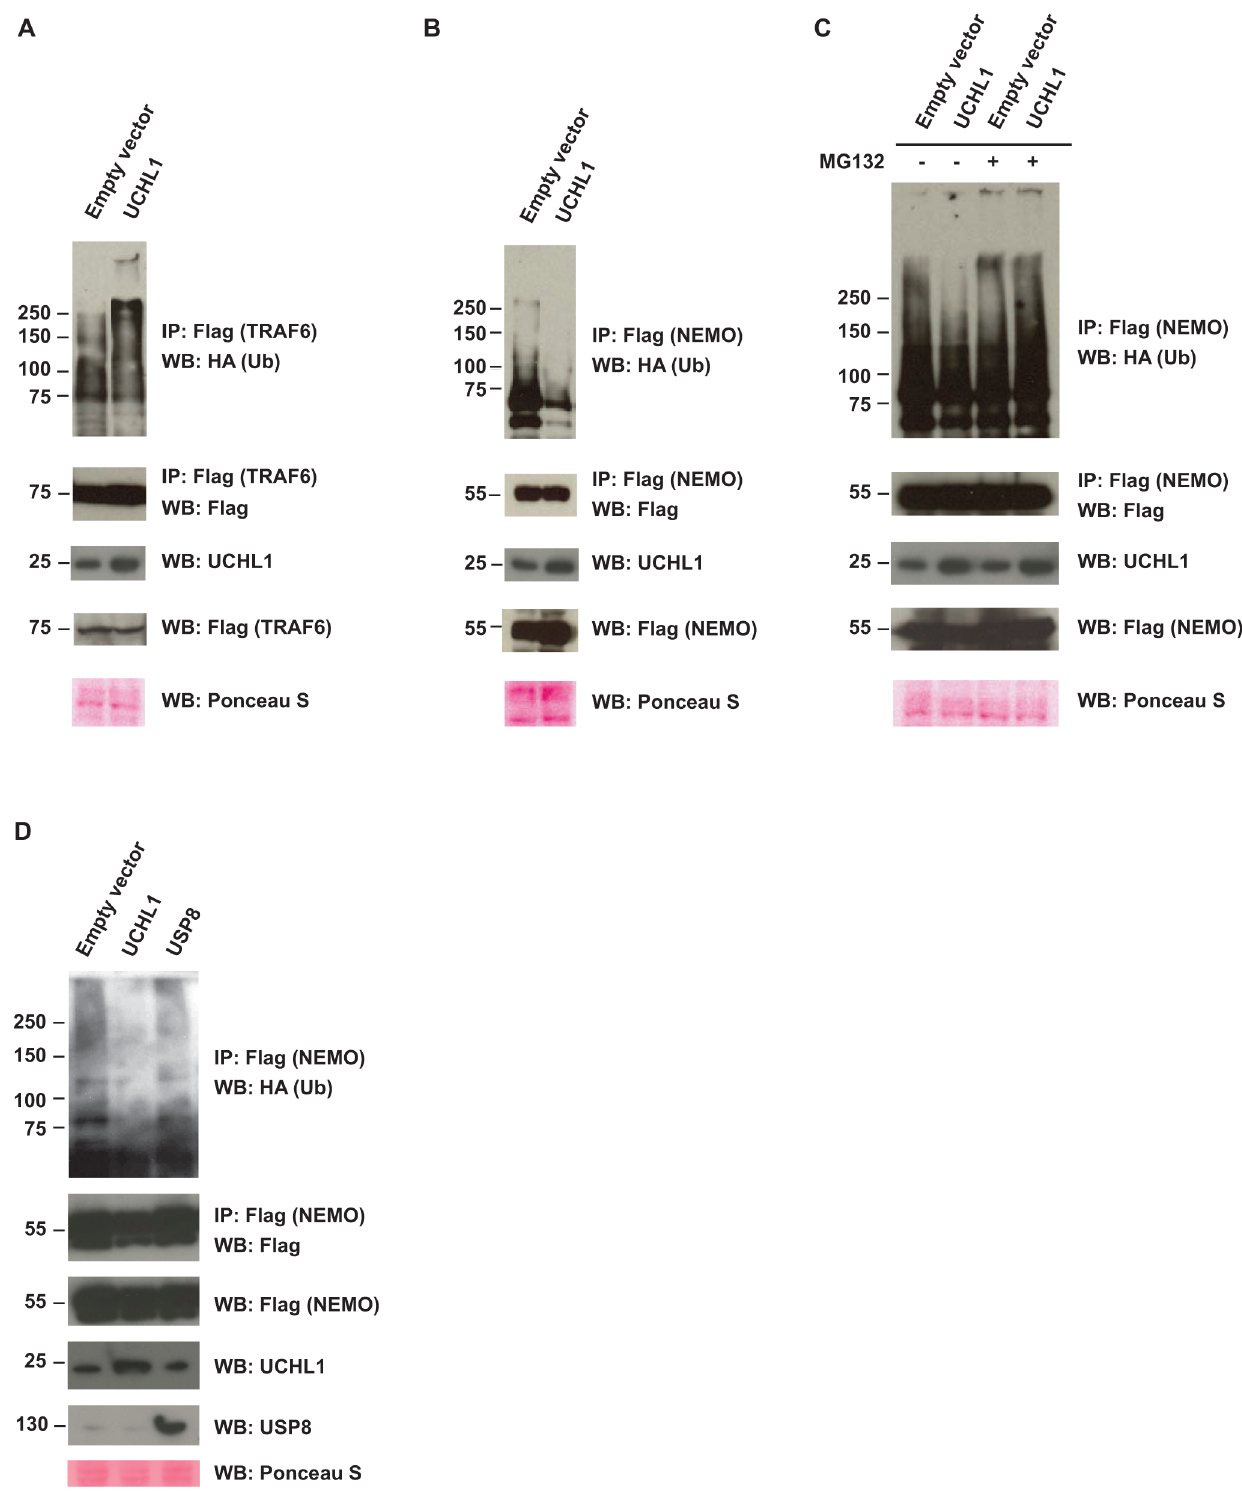
Figure 8. Interaction of UCHL1 with the PRR downstream signaling molecules TRAF6 and NEMO. ( A ) UCHL1 overexpression results in a modest poly-ubiquitination of TRAF6. HEK293T cells were co-transfected with Flag-TRAF6, HA-tagged WT-Ub, and with either empty vector or WT UCHL1. TRAF6 was immunoprecipitated with Flag antibody and western Blotting (WB) was done with HA or Flag antibodies (top two panels). The bottom three panels show a WB analysis of UCHL1 and Flag of non-immunoprecipitated lysate and a Ponceau S stained loading control for WB. ( B ) The effect of UCHL1 on NEMO. HEK293T cells were co-transfected with Flag-NEMO, HA-tagged WT-Ub, and with either empty vector or WT UCHL1. NEMO was immunoprecipitated with Flag antibody and WB was done with HA or Flag antibodies (top two panels). ( C ) The overexpression of UCHL1 mediates the degradation of NEMO. HEK293T cells were co-transfected with Flag-NEMO, HA-tagged WT-Ub, and with either empty vector or WT